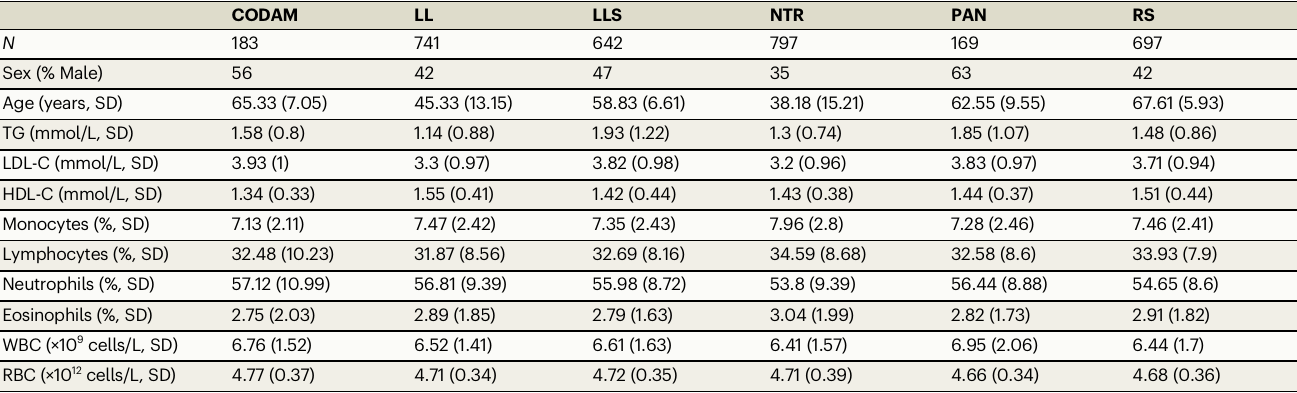
Table 1 | Characteristics of the six cohorts in the BIOS